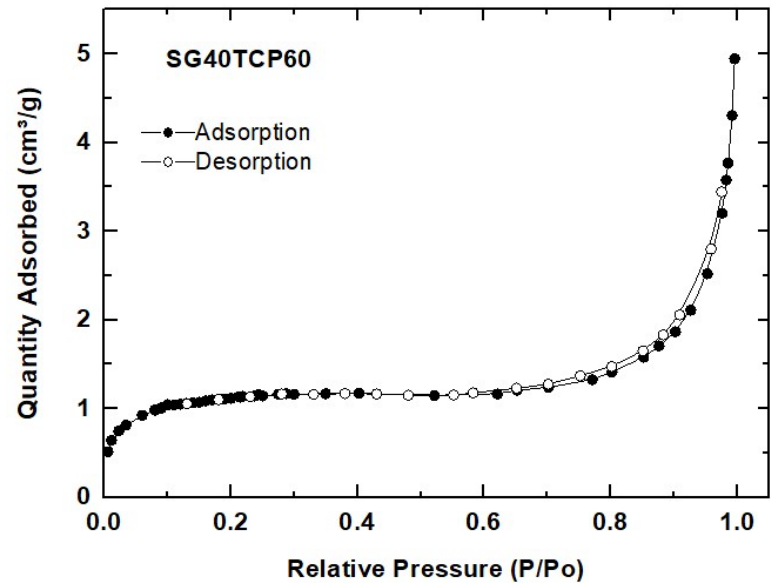
Figure 4. N 2 physisorption isotherm measured for the SG40TCP60 material.